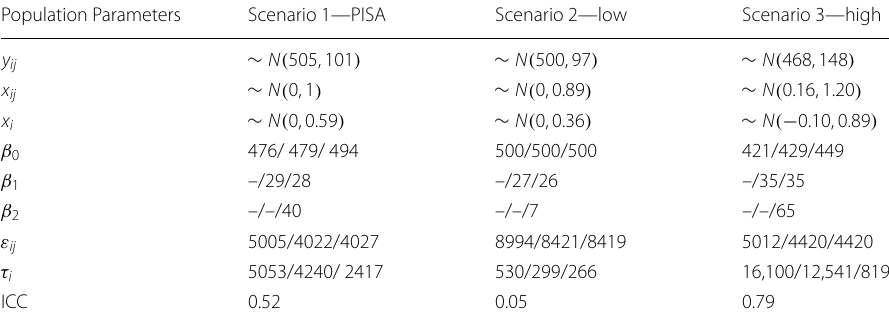
Table 2 Population specifications Population